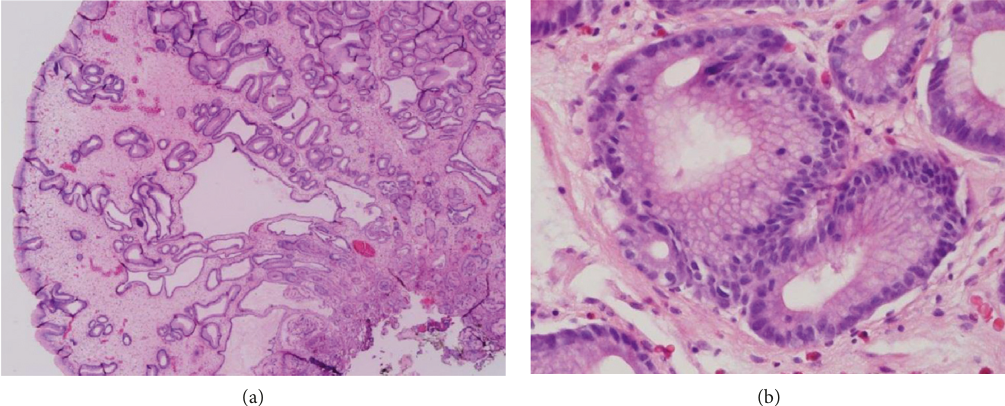
Figure 5: (a, b) Irregular glands with focal cystic dilation, severe edema of the lamina propria, and a sprinkling of eosinophil leukocytes.